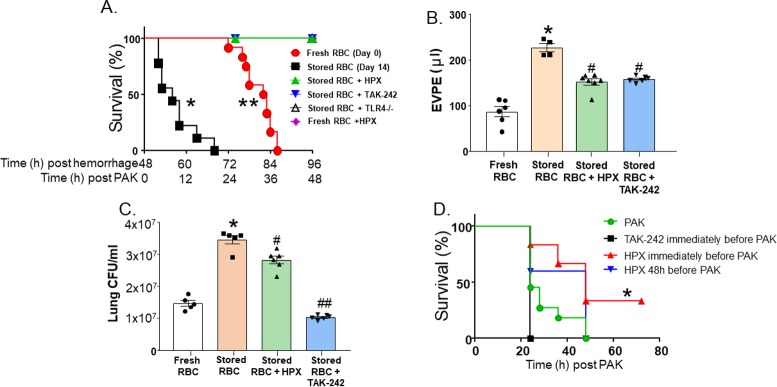
Impairment of lung function secondary to trauma hemorrhage (TH) and resuscitation with stored blood and subsequent pneumonia is heme- and TLR4-dependent.C57BL/6 or TLR4−/− mice underwent TH with fresh or stored red blood cell (RBC) resuscitation (with plasma 1:1) and subsequent P. aeruginosa K-strain (PAK)–induced pneumonia 48 h thereafter. Mice also received vehicle, hemopexin (HPX, 1 mg/kg in 100 μl of PBS) intravenously immediately before resuscitation, or TAK-242 (7.5 mg/kg) intravenously immediately before hemorrhage. (A) Survival after PAK administration. Each symbol represents an individual mouse. Data from fresh (0 storage days, circles, n = 12) or stored (14 storage days, squares, n = 9) RBCs are the same as presented in Fig 1A and collected and pooled over the entire project period as described in Methods. Triangles indicate stored RBCs + HPX (n = 5, *p < 0.001 relative to stored RBCs by log-rank test); inverted triangles indicate stored RBCs + TAK-242 (n = 5, *p < 0.001 relative to stored RBCs by log-rank test); open triangles indicate stored RBCs in TLR4−/− mice (n = 5, *p < 0.001 relative to stored RBCs by log-rank test); diamonds indicate fresh RBCs + HPX (n = 4, **p = 0.002 relative to fresh RBCs by log-rank test). (B) Mice underwent TH and resuscitation with either fresh (n = 6) or stored RBCs (n = 4), stored RBCs and hemopexin (n = 7), or stored RBCs and TAK-242 (n = 6). Forty-eight hours later, PAK was instilled, and 6 h thereafter mice were sacrificed and extravascular pulmonary equivalents (EVPE) measured. Data are mean ± SEM; each symbol represents an individual mouse. *p < 0.001 relative to fresh RBCs and #p < 0.001 relative to stored RBCs by 1-way ANOVA with Tukey post-test. (C) Mice underwent TH and resuscitation with either fresh (n = 5) or stored RBCs (n = 5), stored RBCs and hemopexin (n = 6), or stored RBCs and TAK-242 (n = 6). Forty-eight hours later, PAK was instilled, and 6 h thereafter mice were sacrificed and lung colony-forming units (CFU)/ml measured. Data are mean ± SEM; each symbol represents an individual mouse. *p < 0.001 relative to fresh RBCs and #p = 0.002 and ##p < 0.001 relative to stored RBCs by 1-way ANOVA with Tukey post-test. (D) Mice were administered PAK only by airway instillation (no TH or stored RBC resuscitation) (circles, n = 11), TAK-242 immediately prior to PAK instillation (squares, n = 3), or hemopexin immediately (triangles, n = 6) or 48 h (inverted triangles, n = 5) prior to PAK instillation, and survival monitored. *p = 0.022 for hemopexin administered immediately before PAK relative to PAK alone by log-rank test.